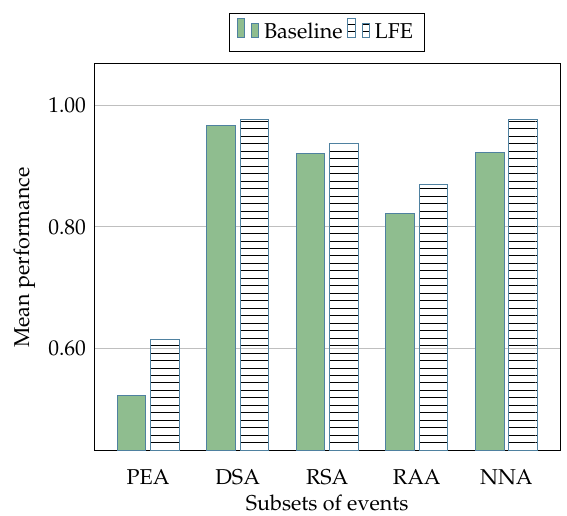
Figure 10. NSL-KDD dataset—overall mean performance in relation to all